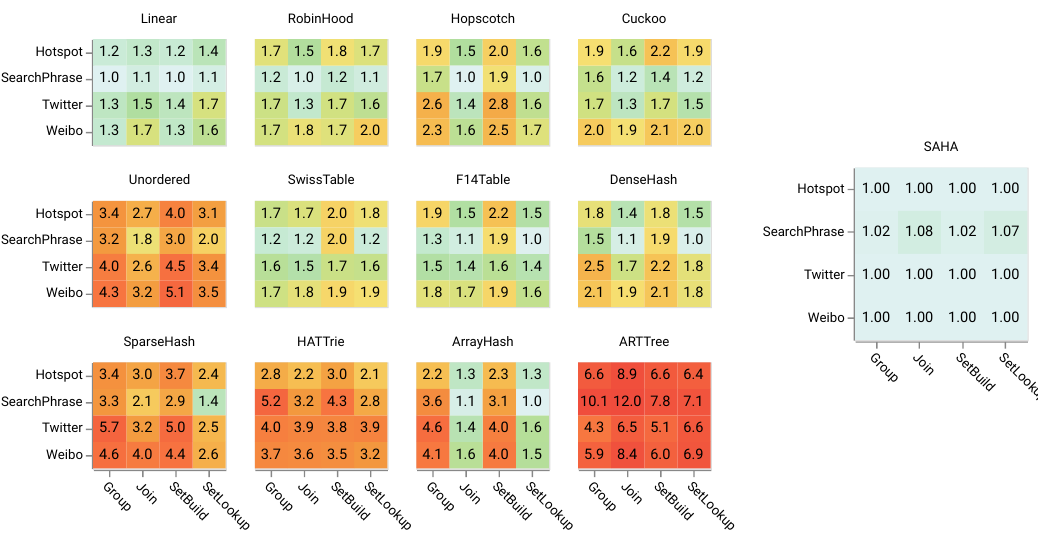
Figure 9. A heat map of slowdowns of various hash tables compared to the fastest of all hash tables for SetBuild, SetLookup, group and join benchmarks, on four datasets with varying string length distributions (HotSpot, Weibo, Twitter, SearchPhrase). Lower numbers (green) are better, with one being the fastest for the specific benchmark running on the specific